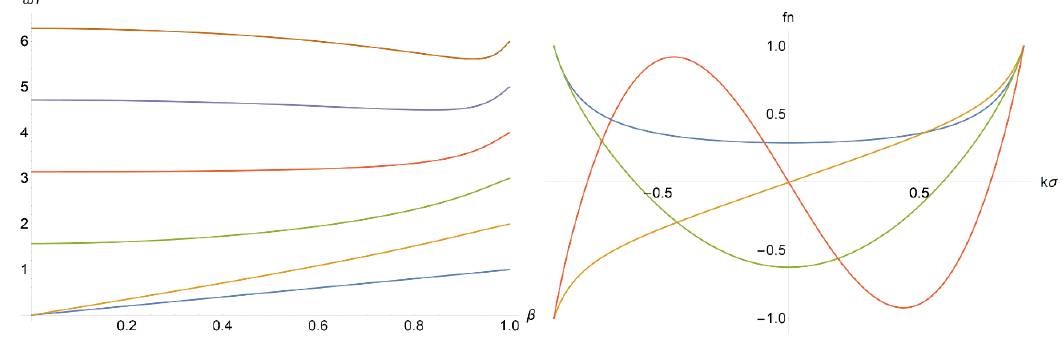
Figure 5 . The (cid:12)rst few eigenfrequencies ( ! n ‘ ) for the planar mode as a function of (cid:12) (left), and the (cid:12)rst few eigenfunctions plotted for (cid:12) = 0 : 9